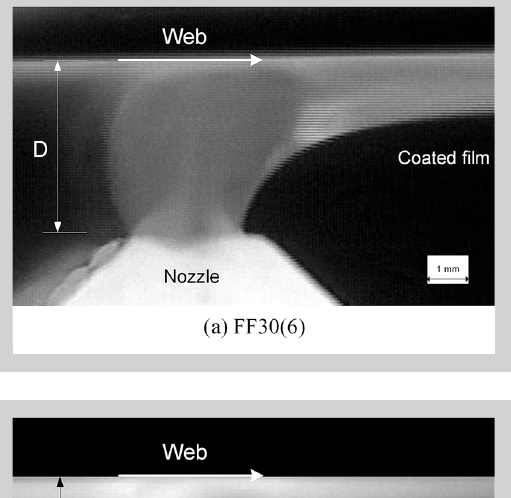
Figure 9 (left): Trouton ratio as a function of the effective strain rate for all the fluids. Figure 10: Jet flow image from application region at U = 12.5 ms -1 with a) (right above) FF30 and b) (right middle) C55-1. Figure 11 (right below): Downstream meniscus configuration for U = 8.3 ms -1